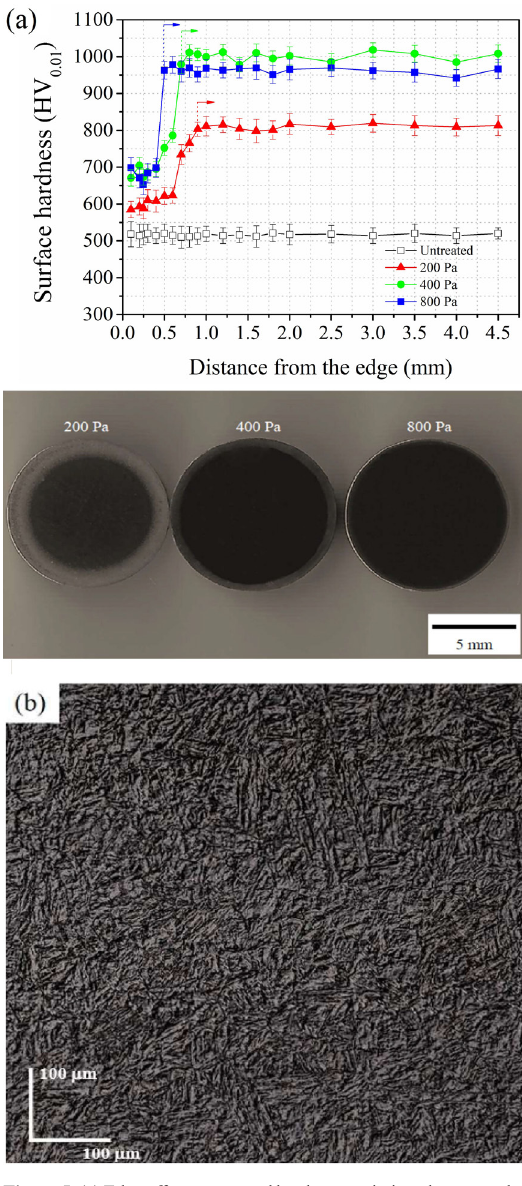
Figure 5. (a) Edge effect aspect and hardness variation along samples of the pressure treatment series; and (b) Typical surface topography images of the sample treated at 800 Pa / 700 V. Treatments carried out at 450 °C, for 8 h, using 99.5% (80% H CH gas mixture at 1.67 × 10 −6 Nm 3 s −1 flow rate. 4